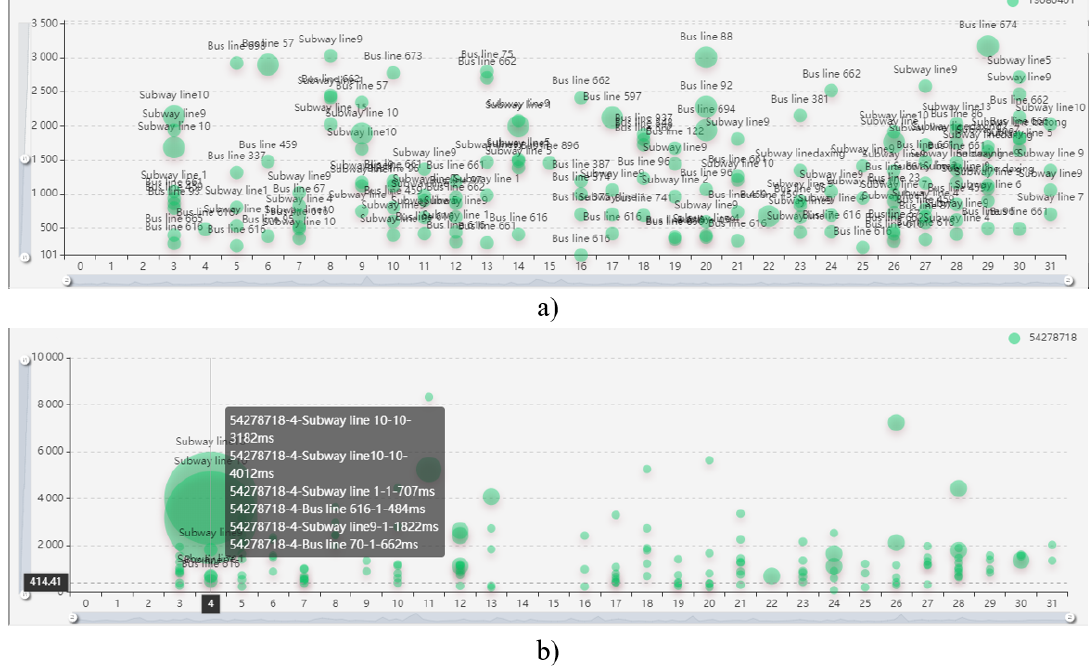
Figure 19. Passenger travel vehicle bubble chart view ( a ) Card number 13080401, ( b ) Card number